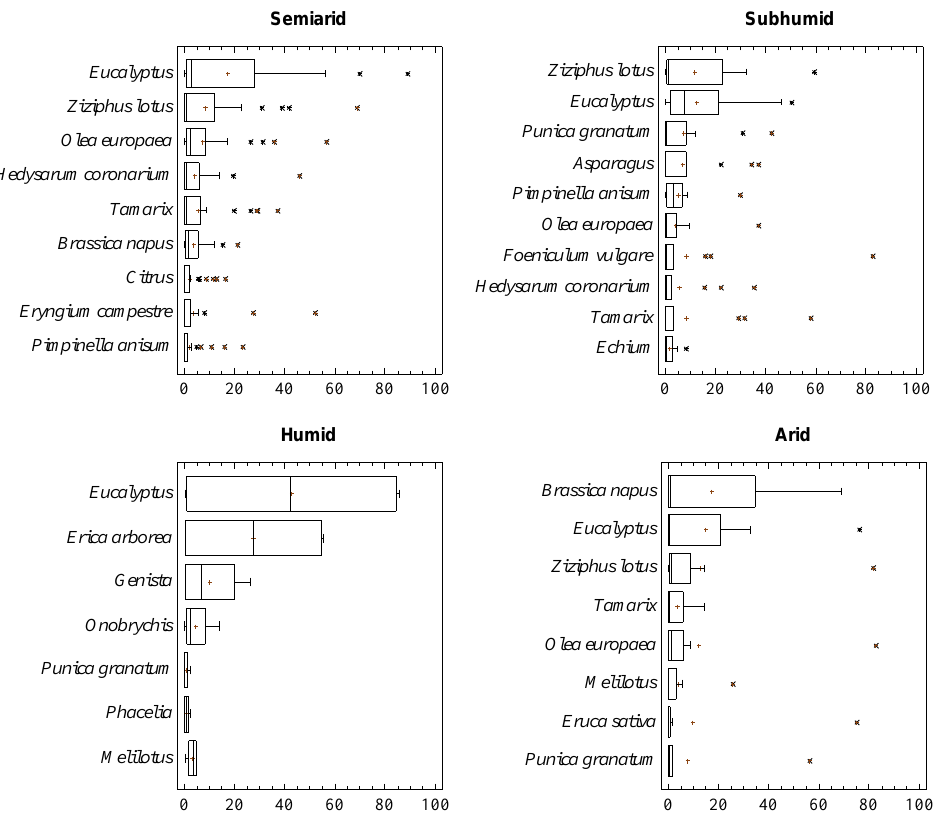
Figure 2. Box and Whisker plot of the main pollen types in each area. * Atypical values, +, Centroids